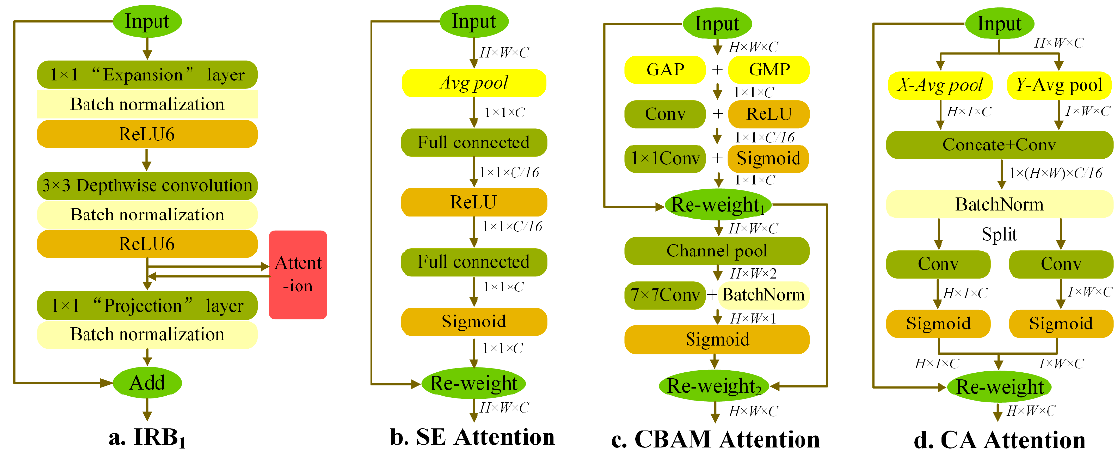
Figure 4. Diagram of different attention mechanisms. ( a ) IRB 1 ; ( b ) SE Attention; ( c ) CBAM Attention; ( d ) CA Attention.